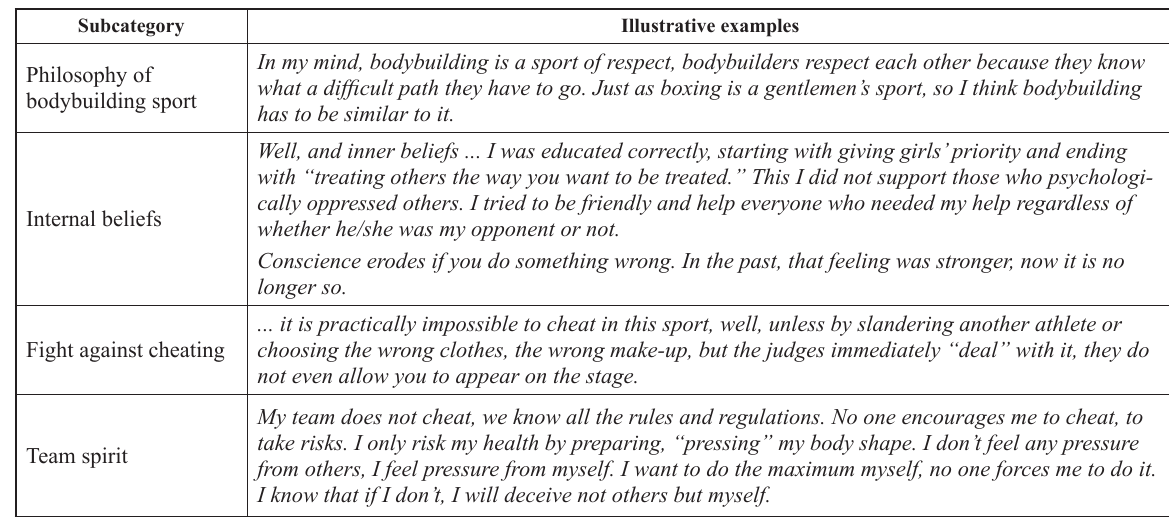
Table 4. Category: Positive circumstances Subcategory Illustrative examples Philosophy of bodybuilding